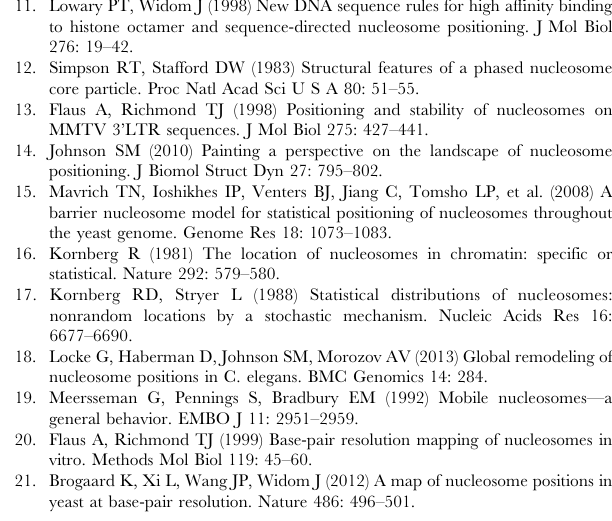
Tables S1 Excel file of Pearson’s Correlation